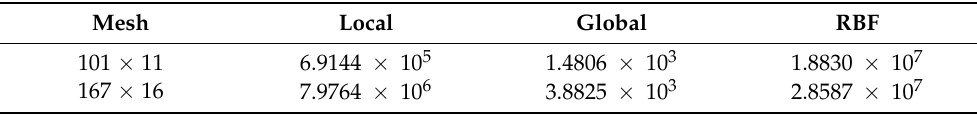
Table 11. Example No. 3—values of condition numbers, eight virtual boundary and six inter- nal